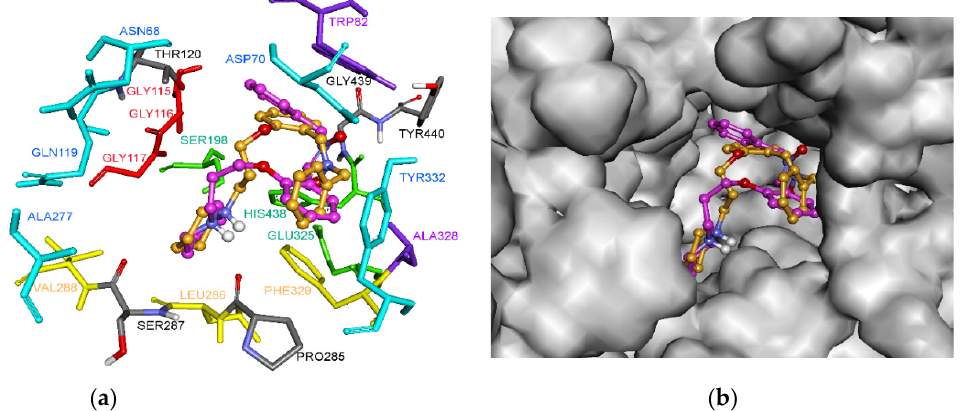
Figure 2. Proposed binding modes for nitrone 5 in the active site of hBChE. Nitrone 5 in mode I, the carbon atoms are shown in pink (binding energy: –9.4 kcal/mol). Nitrone 5 in mode II is shown in orange (binding energy: –9.2 kcal/mol). ( a ) The different subsites of the active site are colored as follows: catalytic Ser198 and His438 in green, oxyanion hole in red, CBS in violet, ABP in yellow, and PAS in blue; ( b ) Outer surface of the hBChE active site, with both binding poses of nitrone 5 .